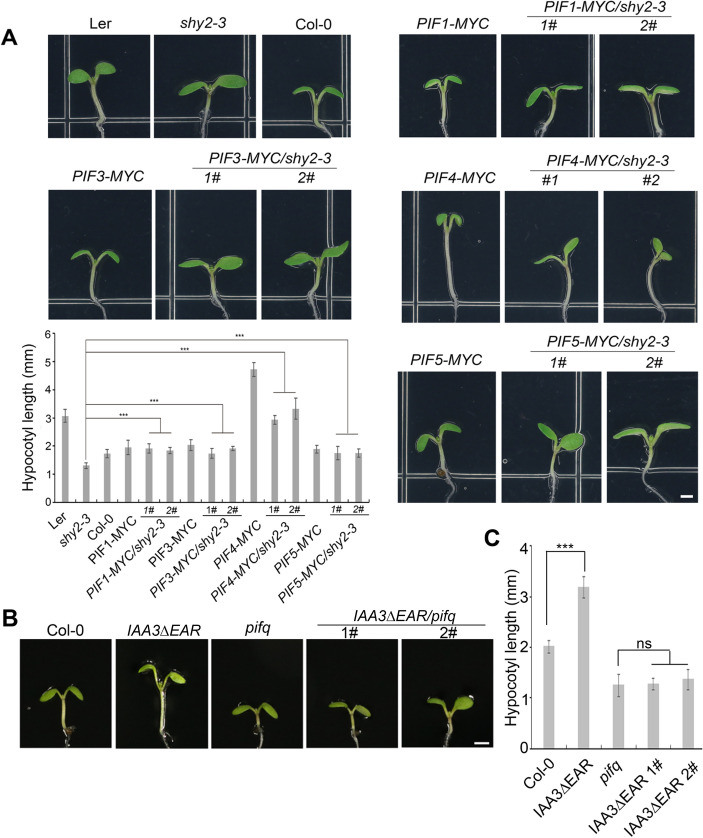
IAA3 and PIFs cooperatively regulate hypocotyl elongation.(A) Overexpression of PIF genes rescues the shortened hypocotyl phenotype of shy2-3. The images show representative 5-day-old seedlings of Ler, shy2-3, Col-0, PIF1-MYC, PIF1-MYC/shy2-3, PIF3-MYC, PIF3-MYC/shy2-3, PIF4-MYC, PIF4-MYC/shy2-3, PIF5-MYC, and PIF5-MYC/shy2-3. PIF-MYC indicates 35S-PIF-MYC transgenic plants. The left bottom is the bar graph of the measured hypocotyl lengths of the genotypes indicated. Error bars represent SD (n ≥ 15). Student’s t-tests between mutant/transgenic and mutant seedlings were performed (***P < 0.001). (B) 5-day-old plants of Col-0, 35S-IAA3ΔEAR-VP16 transgenic plant (IAA3ΔEAR), pifq and the 35S-IAA3ΔEAR-VP16 transgenic line in pifq background (IAA3ΔEAR/pifq). (C) Bar graph of the measured hypocotyl lengths of the genotypes indicated in (B) Error bars represent SD (n ≥ 15, ***P < 0.001, ns represents P > 0.05).